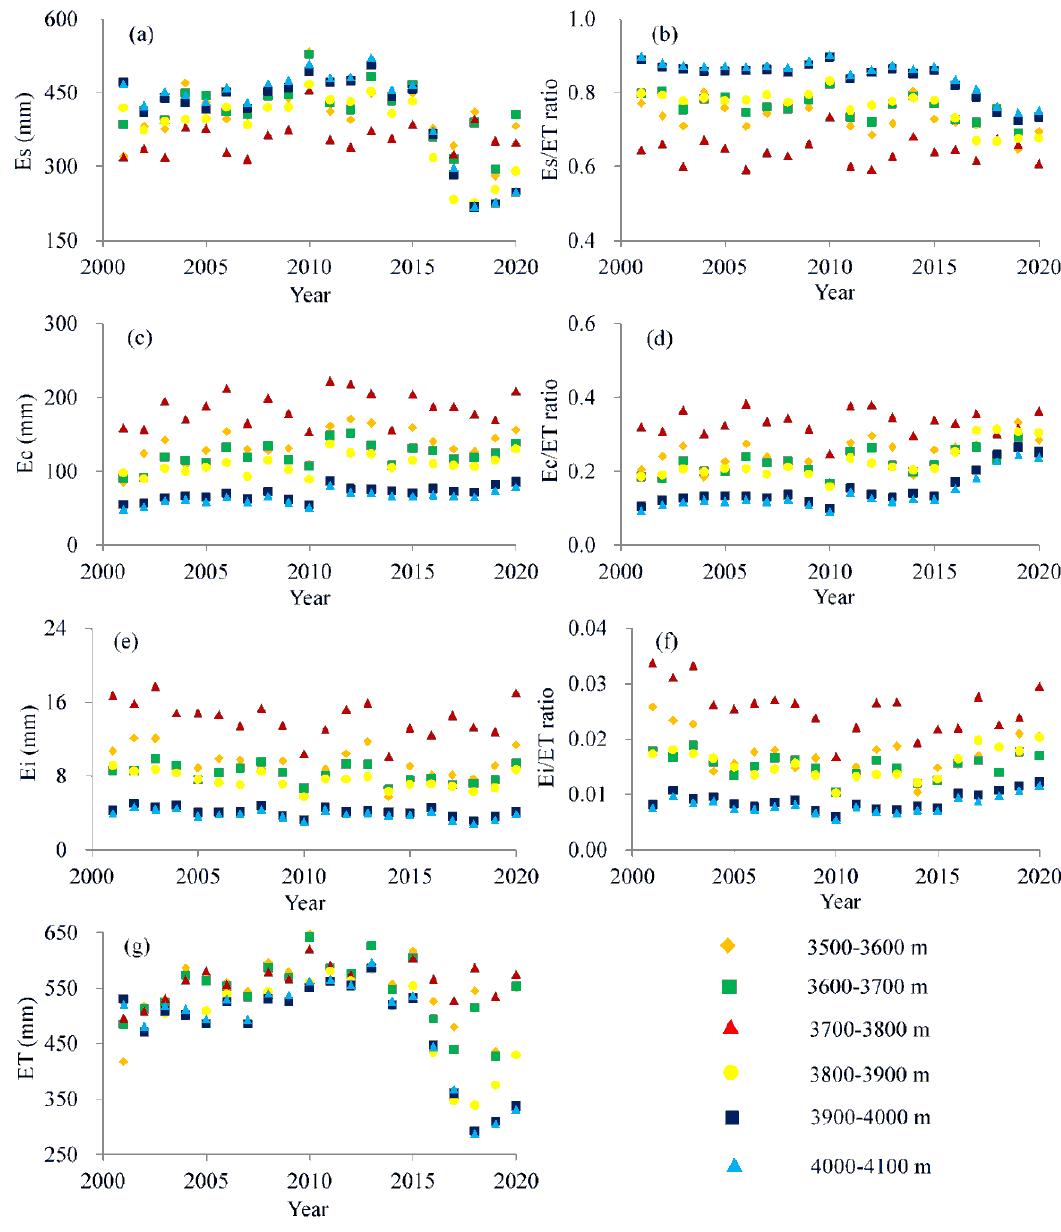
Figure 4. Variations in Es ( a ), Es/ET ( b ), Ec ( c ), Ec/ET ( d ), Ei ( e ), Ei/ET ( f ), and ET ( g ) of highland barley during 2001–2020. ET components were not correlated significantly with meteorological variables (Table